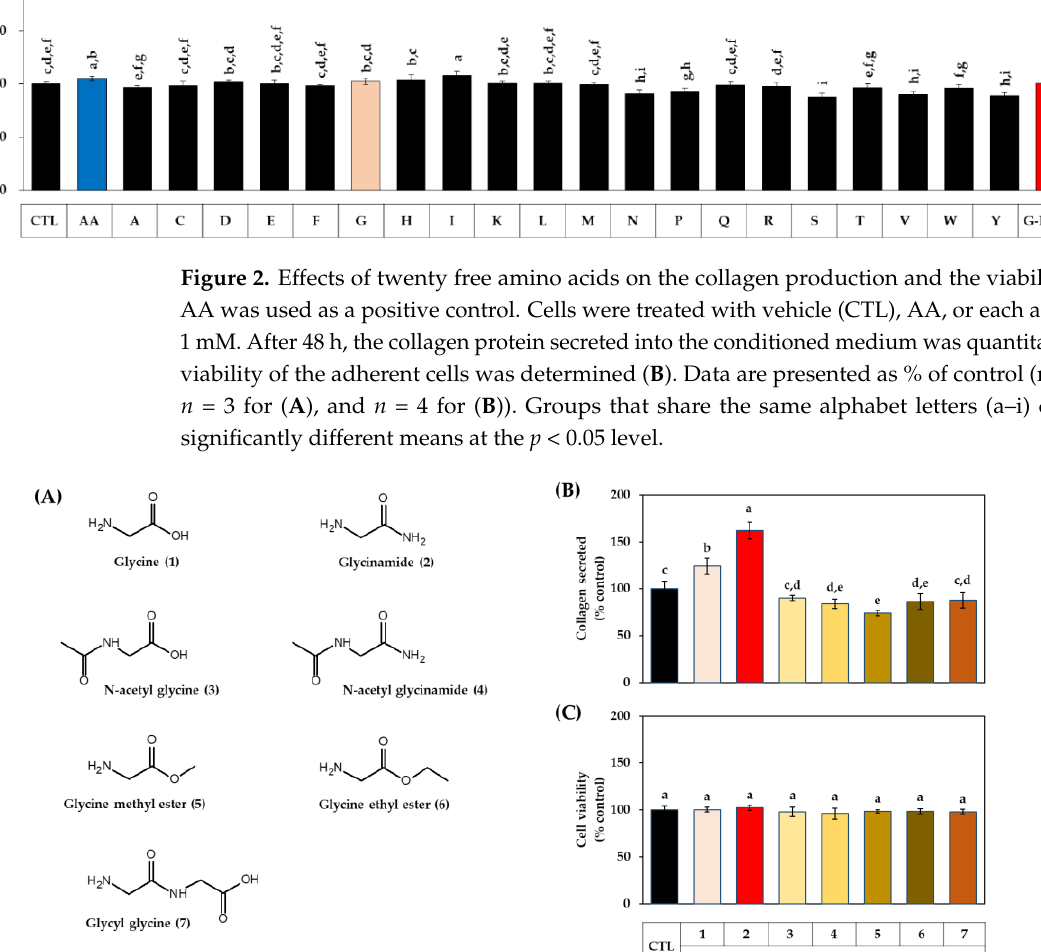
Figure 2. Effects of twenty free amino acids on the collagen production and the viability of HDFs. AA was used as a positive control. Cells were treated with vehicle (CTL), AA, or each amino acid at 1 mM. After 48 h, the collagen protein secreted into the conditioned medium was quantitated ( A ). The viability of the adherent cells was determined ( B ). Data are presented as % of control (means ± SD, n = 3 for ( A ), and n = 4 for ( B )). Groups that share the same alphabet letters (a – i) do not have significantly different means at the p < 0.05 level.